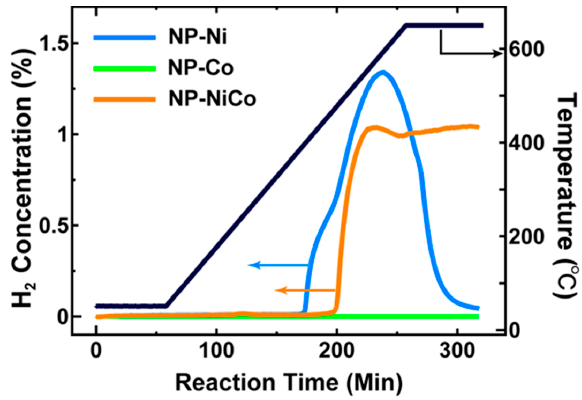
Figure 1. Concentrations of H 2 in outlet gases for NP ‐ Ni, NP ‐ Co, and NP ‐ NiCo samples, as well as the change in temperature over time.